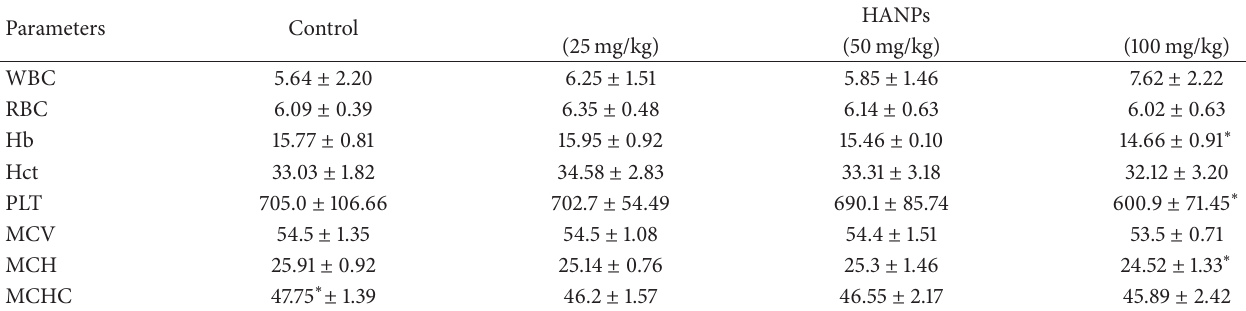
Table 2: Haematological values of rats when exposed to HANPs (mean ± SD, 𝑛 = 5 ). Parameters